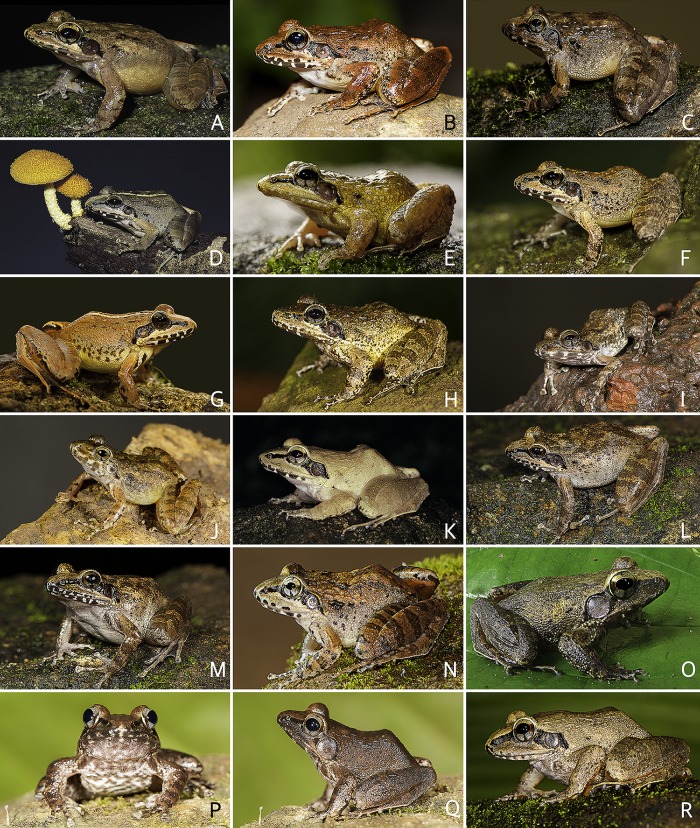
Indirana beddomii group in life.(A–B) I. beddomii. (A) An adult male (SDBDU 2010.225), from Kakkayam. (B) An adult female (SDBDU 2011.960), from Silent Valley. (C) Indirana bhadrai, holotype, an adult female (ZSI/WGRC/V/A887), from Muthodi. (D–H) I. brachytarsus. (D) An adult female (not preserved), from Ponmudi. (E) An adult male (SDBDU 2011.541), from Parambikulam. (F) An adult male (SDBDU 2006.4800), from Anchuruli. (G) An adult female (SDBDU 2011.280), from Pandimotta. (H) An adult male (SDBDU 2015.2995), from Upper Manalar. (I, J) I. leithii. (I) An adult female (SDBDU 2014.2514), from Matheran. (J) An adult male, (SDBDU 2011.1095), from Bhimashankar. (K) I. sarojamma, an adult female (SDBDU 2002.516) from Chathankod–Bonnacaud. (L–N) I. tysoni. (L, M) An adult female (SDBDU 2012.73), from Coorg. (L) Dorsolateral view. (M) Frontolateral view. (N) An adult male (SDBDU 2012.2228), from Coorg. (O–R) I. yadera. (O) An adult male (SDBDU 2012.2744), from Methooty. (P, Q) An adult male (SDBDU 2015.2984), from Kozhikana. (P) Frontal view. (Q) Dorsolateral view. (R) An adult female (SDBDU 2015.3155), from Vazhachal.